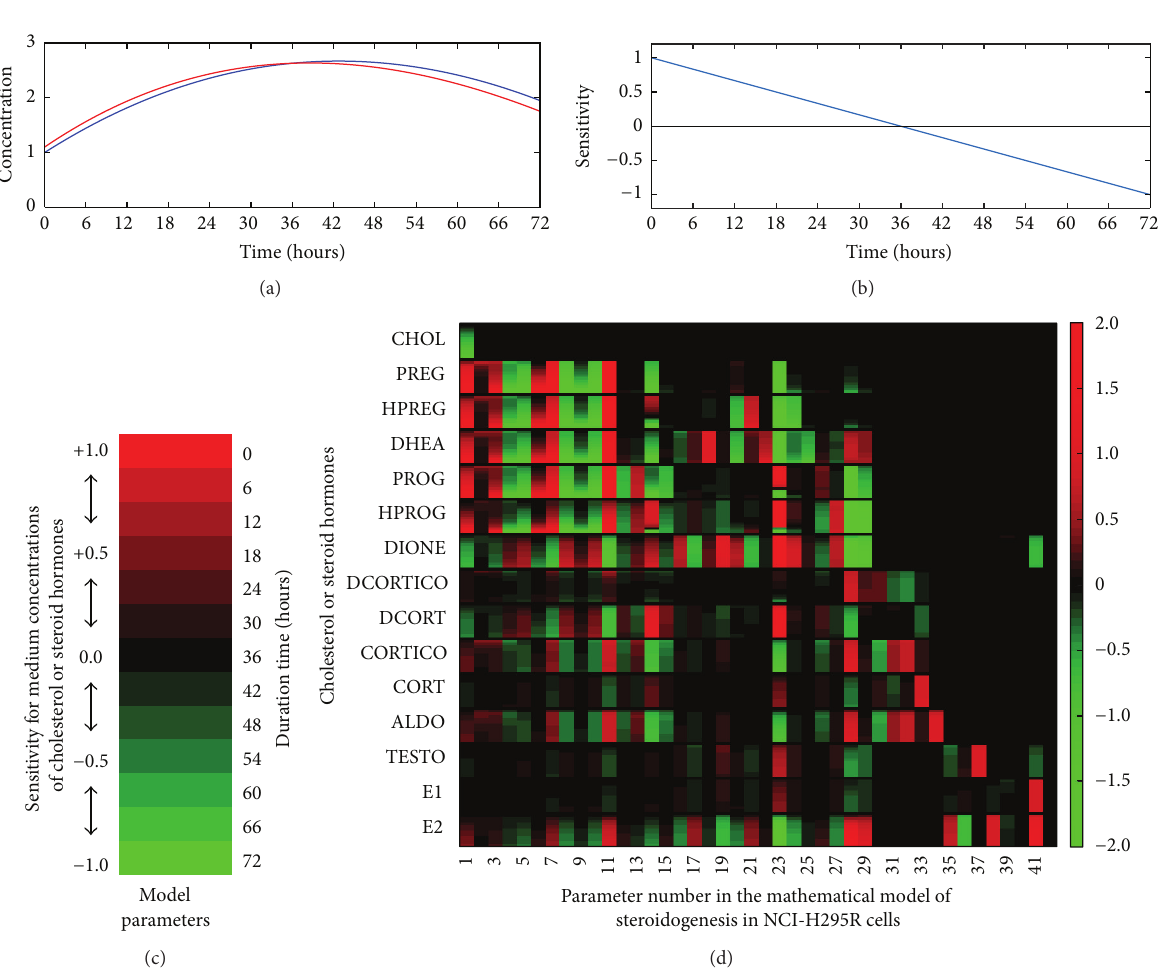
Parameter number in the mathematical model of steroidogenesis in NCI-H295R